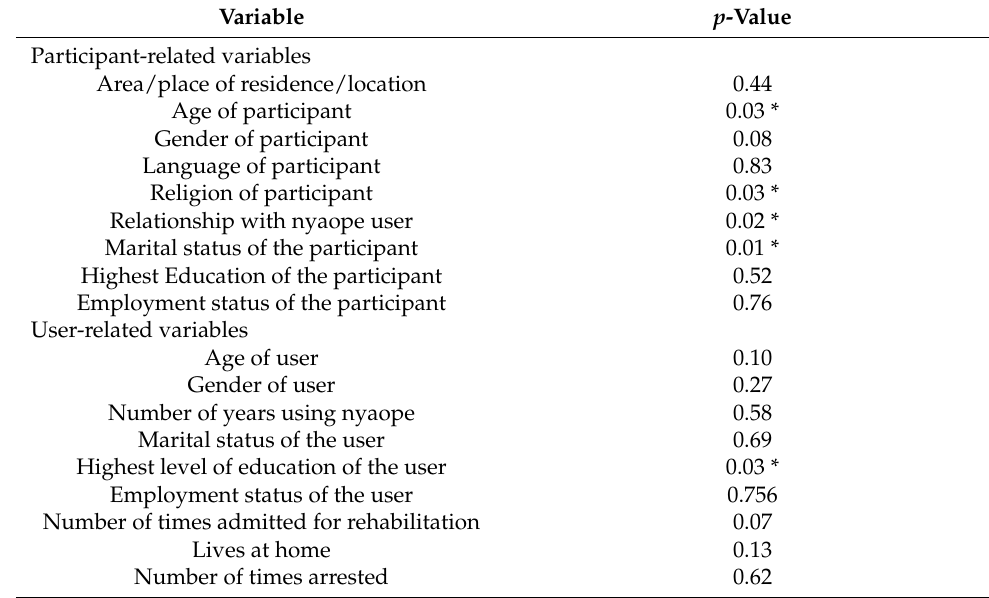
Table 5. Factors associated with the development of depression